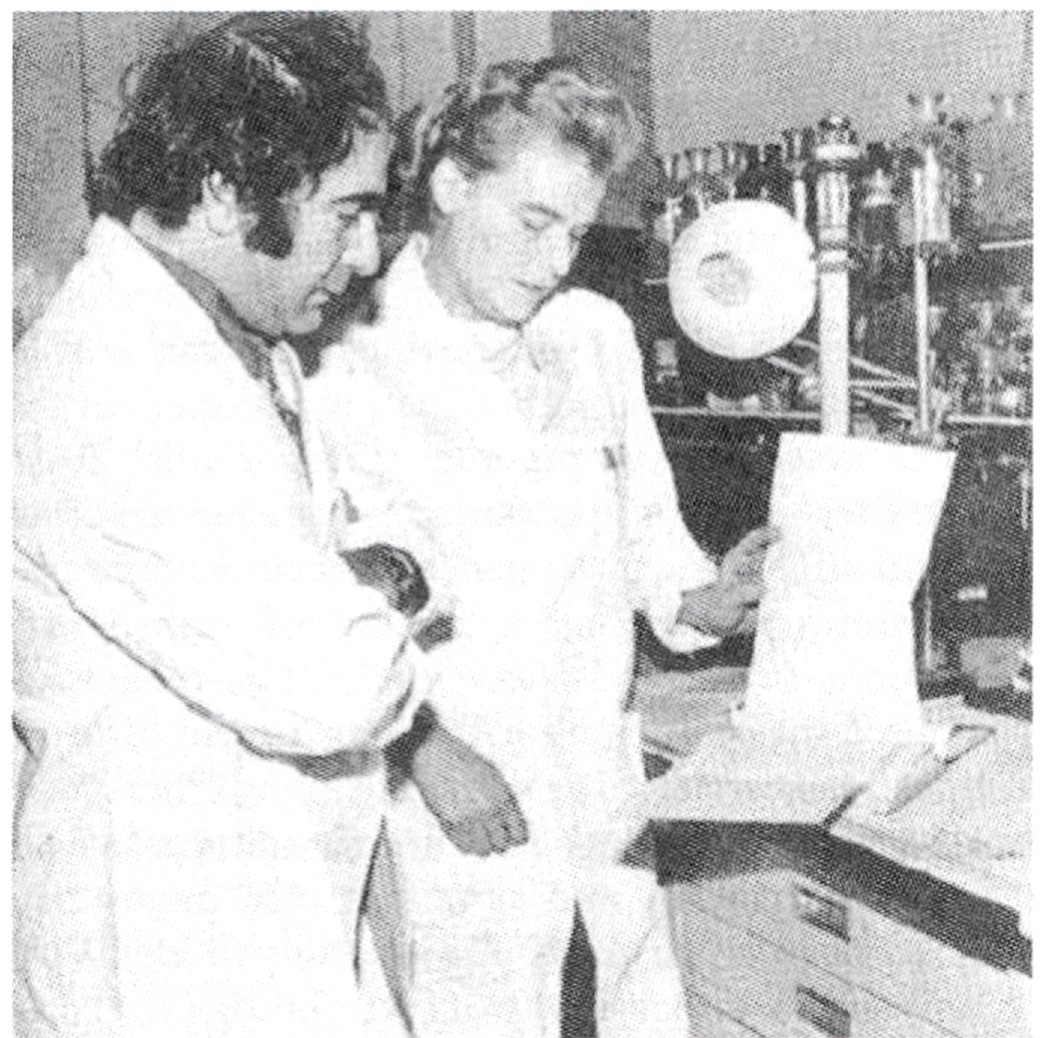
Figure 1. Brenda Ryman with the author ( circa 1971).